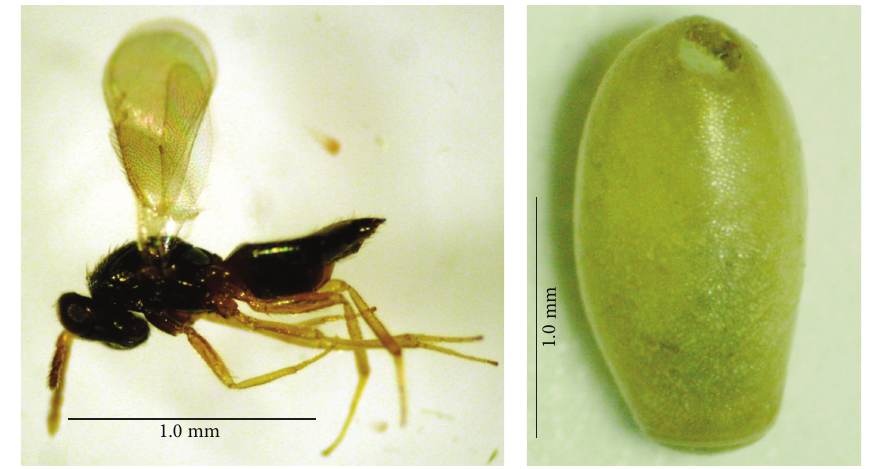
Figure 1: Parasitoid wasp Aprostocetus asthenogmus (Waterston, 1915) and Triatoma vitticeps (St˚al, 1859)